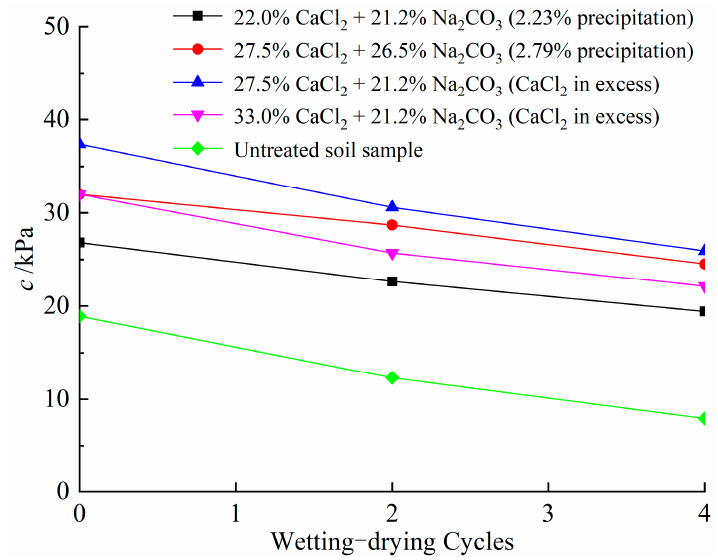
Figure 14. Variations in cohesion versus wetting–drying cycles.